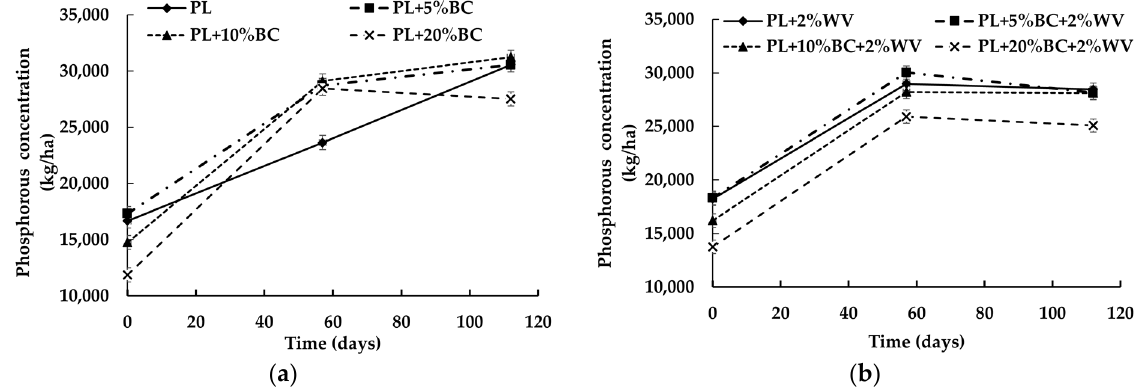
Figure 5. Phosphorous concentration (kg/ha) for poultry litter blends without WV ( a ) and with WV ( b ) over time.